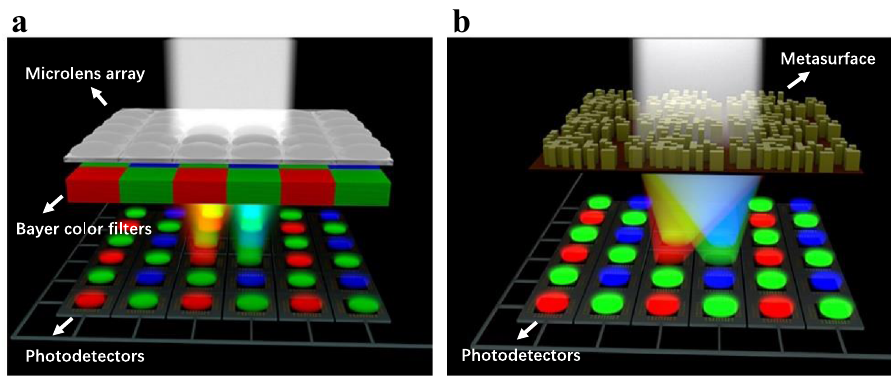
Fig. 1 Comparison between the fi ltering principles of traditional BCF and the routing principle of the MBCR. a Schematic of the traditional imaging system with BCF, microlens array and CMOS imaging sensor. b Schematic of the imaging system with MBCR and CMOS imaging